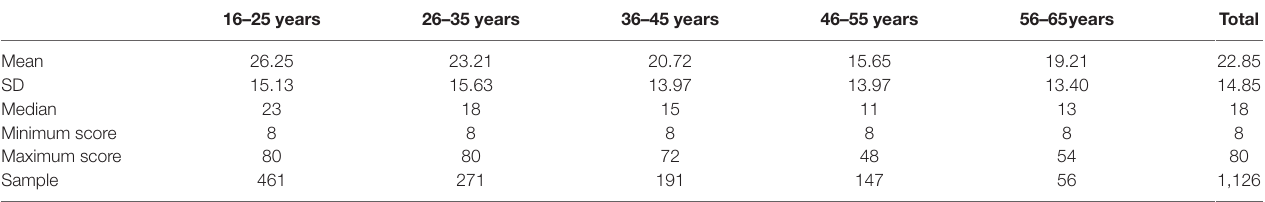
Table 4 | Mobile Phone addiction craving scale (MPacs) scores for age